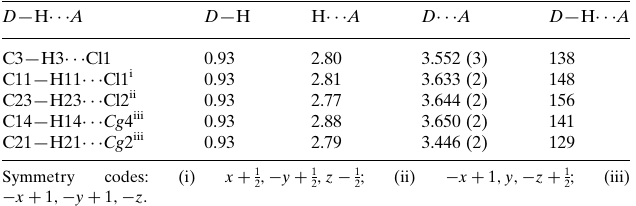
Hydrogen-bond geometry (A˚ , (cid:4) ). Cg 2 and Cg 4 are the centroids of the C19–C24 and C7-C12 benzene rings,